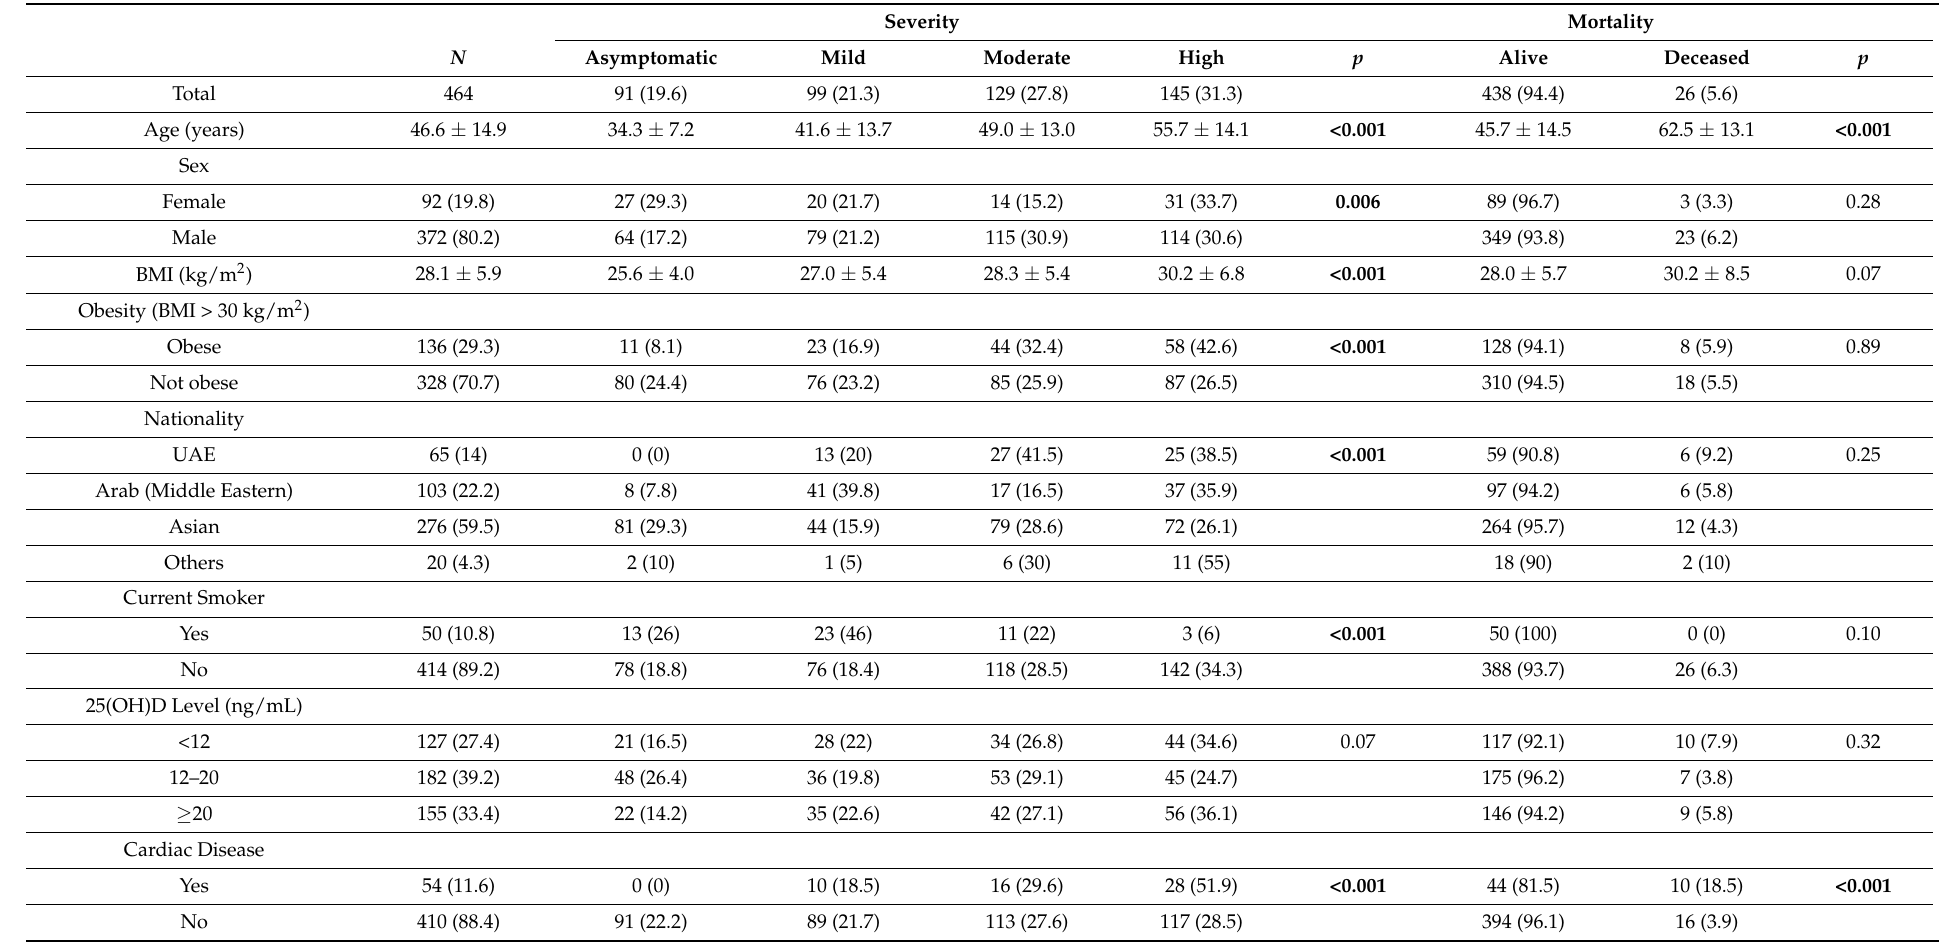
Table 1. Characteristics of COVID-19 patients according to disease severity and